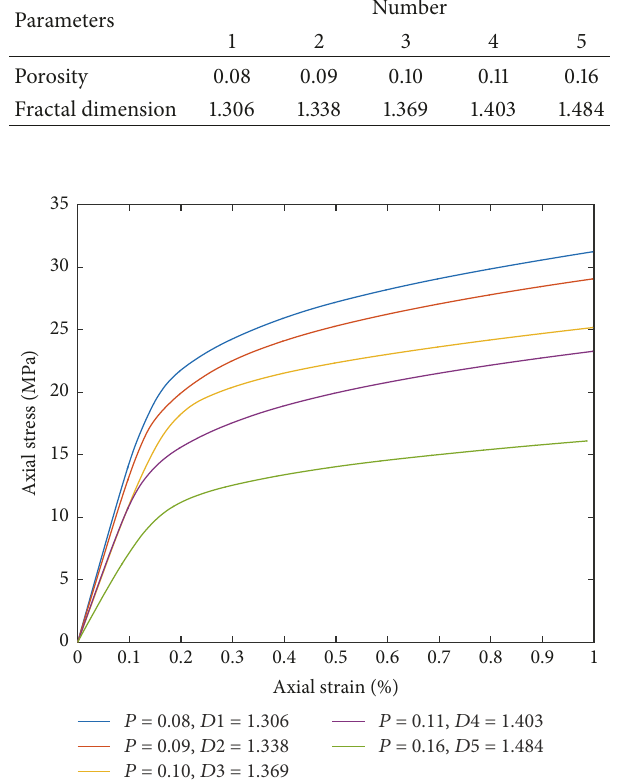
Table 3: The porosity and fractal dimension of the RVEs. Parameters